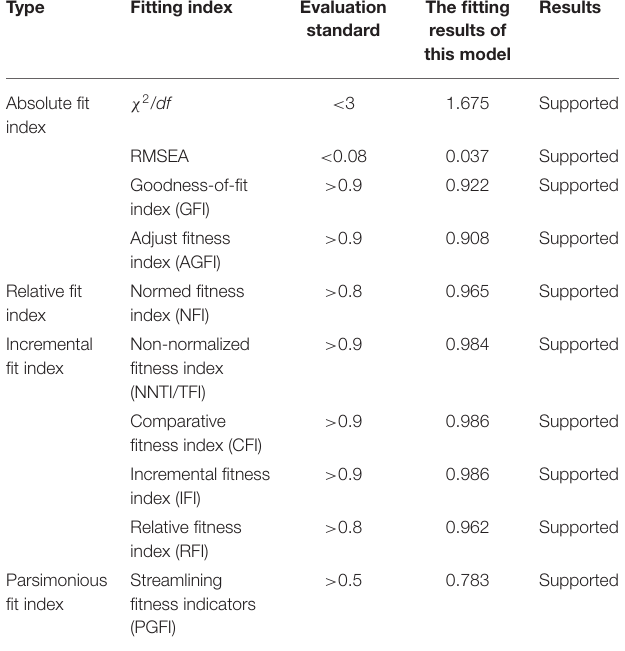
TABLE 4 | Model fitting analysis.